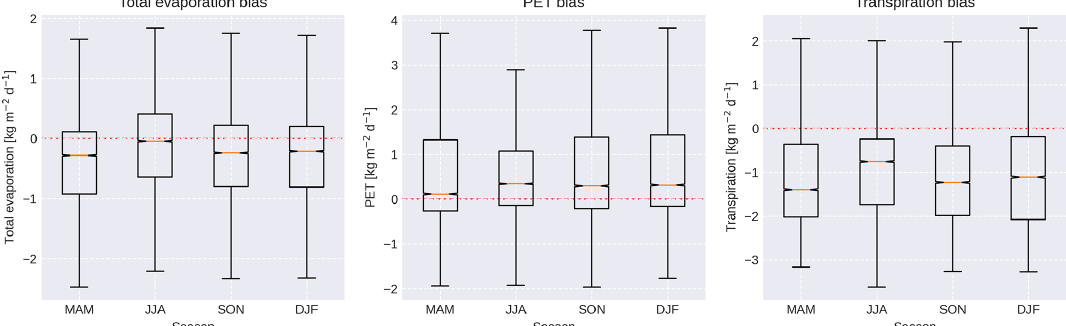
Figure 7. Percentile distribution of biases in the differences of seasonal mean fields between HydroPy and GLEAM data between 20 and − 20 ◦